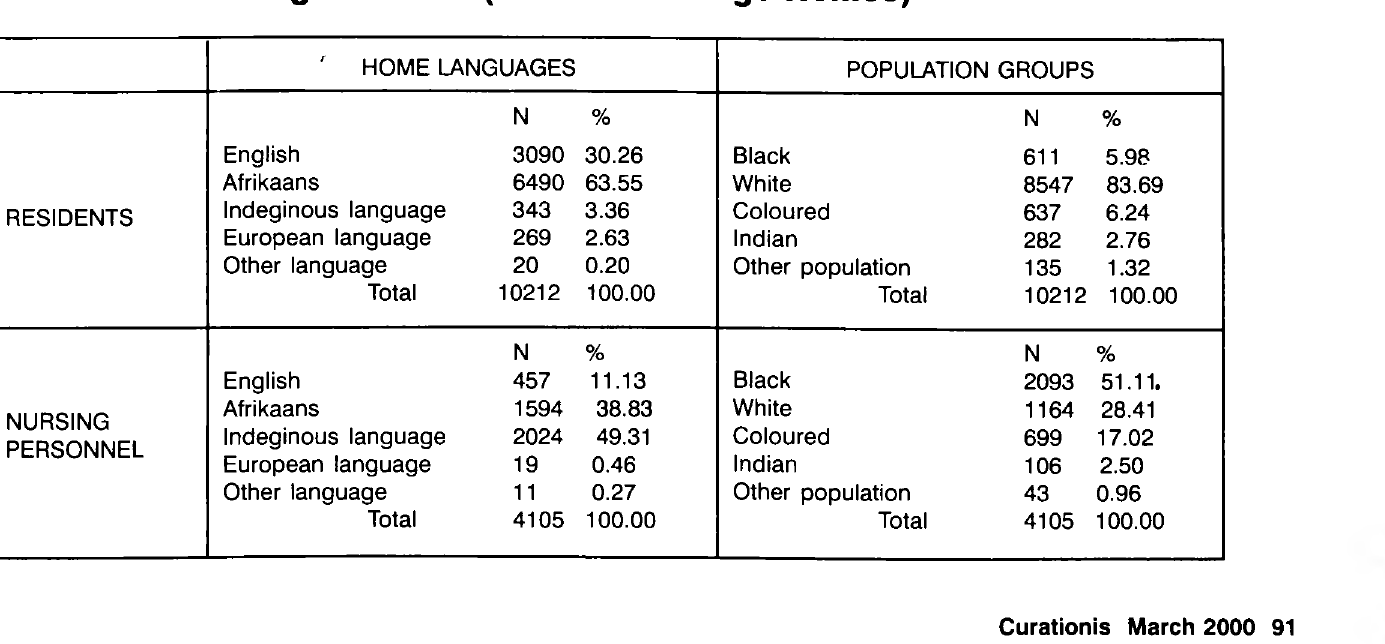
Table 2: The home language and population groups of residents and nursing personnel in old age